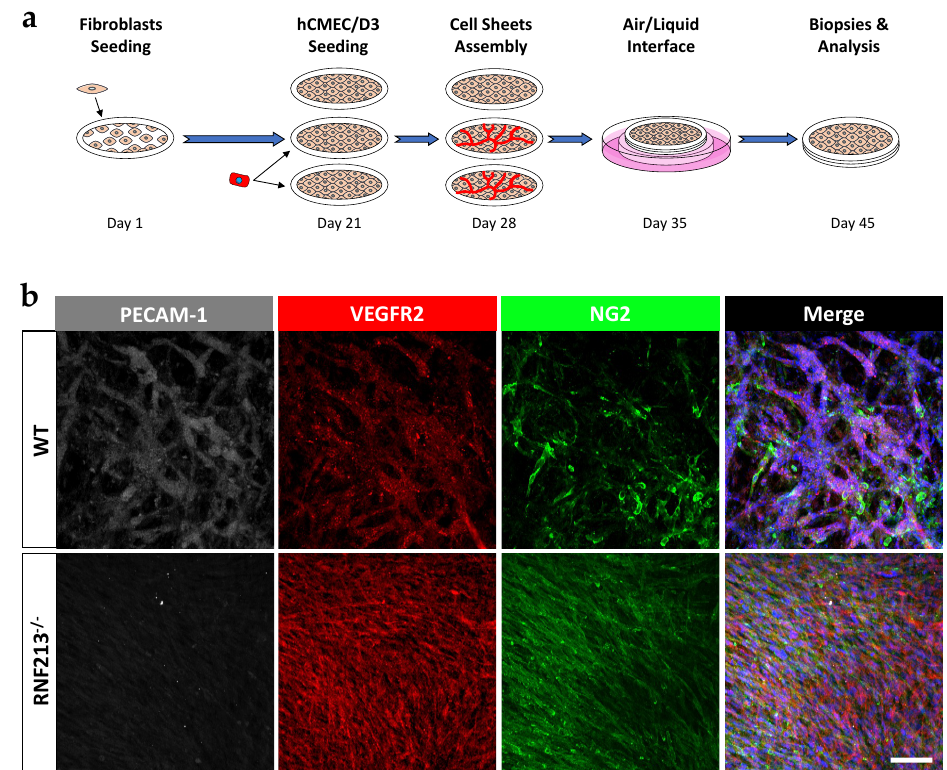
Figure 6. RNF213 deficiency is associated with the formation of moyamoya-like vessels in vitro. ( a ) Timeline of the experimental procedure to generate 3D vascularized constructs using the self- assembly method of tissue engineering. Briefly, epineural fibroblasts were seeded and cultured for 21 days in presence of ascorbic acid. HCMEC/D3 were then added on the second and third cell sheets and cultured in a submerged condition for 7 days. Three cell sheets were stacked, cultured for an additional 7 days and raised at air-liquid interface for 10 days; ( b ) Visualization of the 3D microvascular networks by immunofluorescence staining for PECAM-1 (grey) and VEGFR2 (red) that were imaged by confocal microscopy. Pericyte-like cells were immunostained with NG2 (green). Nuclei were stained with Hoechst (blue). Scale bar = 100 µ